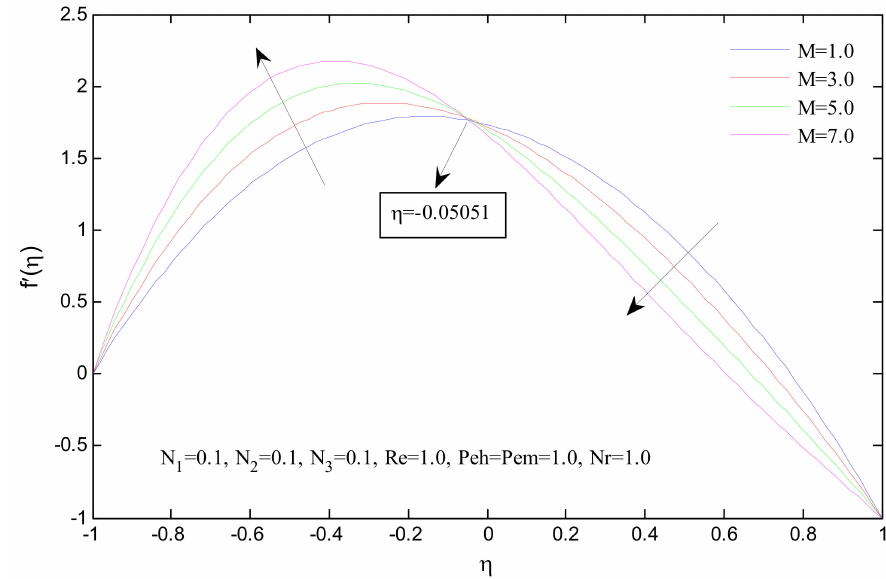
Figure 6. Effect of M on simulated velocity.